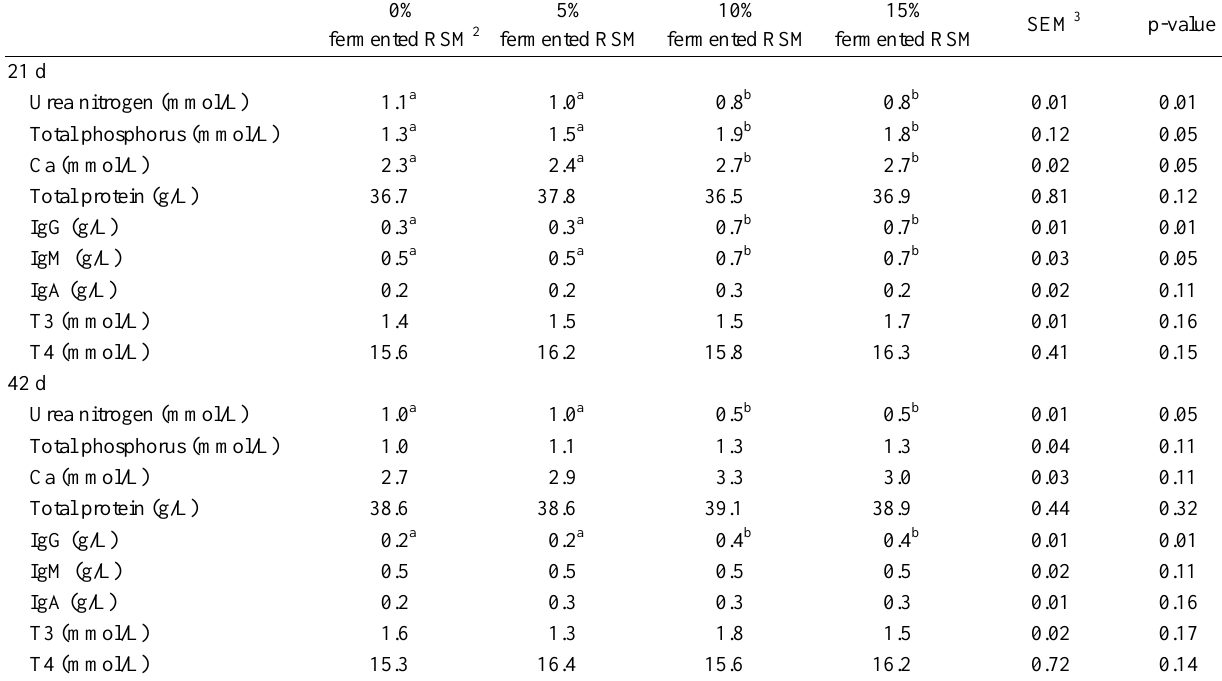
Table 4. Effect of fermented RSM on serum variables in broilers